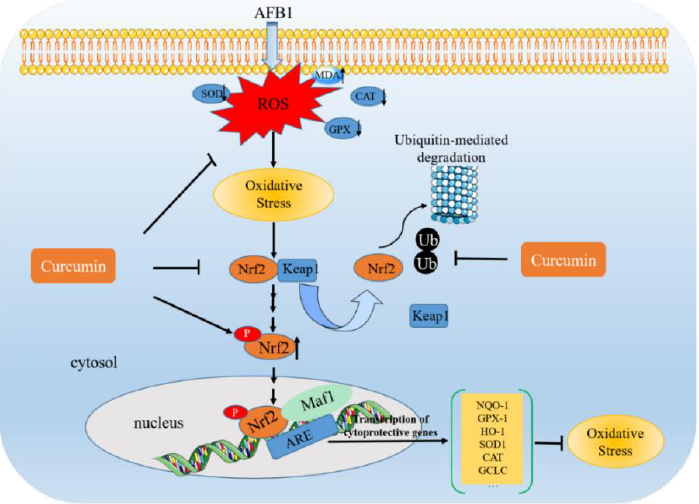
Figure 2. Curcumin improves AFB1-induced toxicity via inhibiting the production of ROS and oxidative stress and activating the Nrf2-mediated antioxidant defense system.